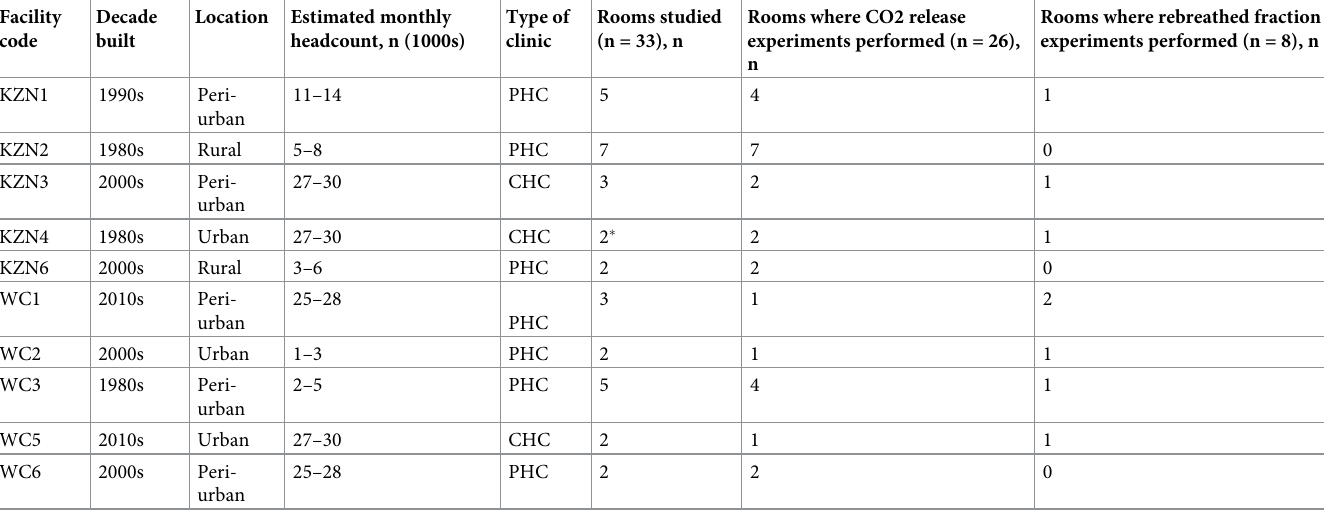
Table 1. Characteristics of facilities (n = 10) and rooms (n = 33) in which ventilation experiments were conducted.